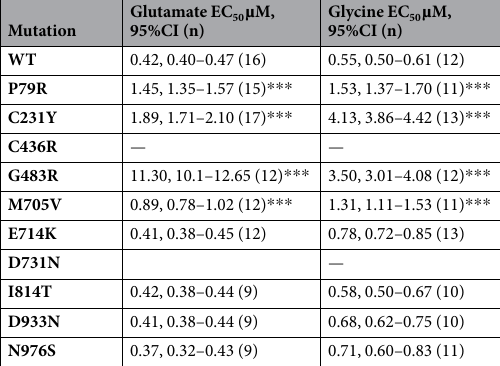
Table 2. Summary of Glutamate and Glycine EC 50 for wild type and mutant GluN2A constructs. Data expressed as mean (95% confidence intervals). N = number of wells from the single cell calcium imaging assays (3–6 assays). When no values are given this is because there was no detectable response. *** P < 0.0001 Bonferroni corrected extra-sum-of-squares F-test of best-fit values of LogEC 50